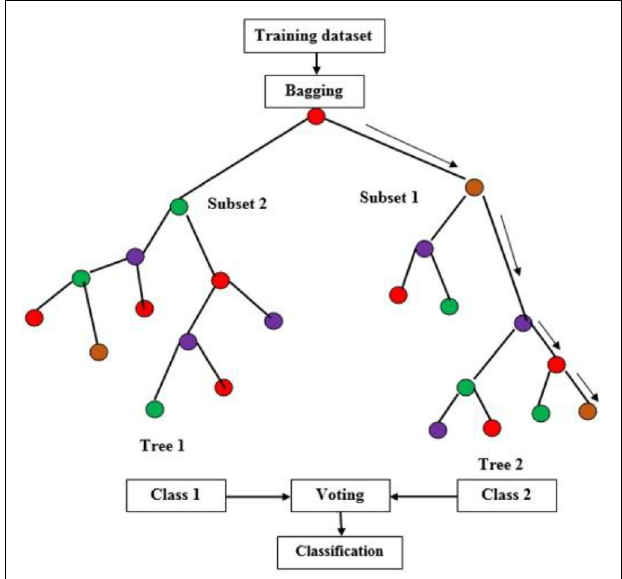
FIGURE 5 | Flow chart of classification using machine learning